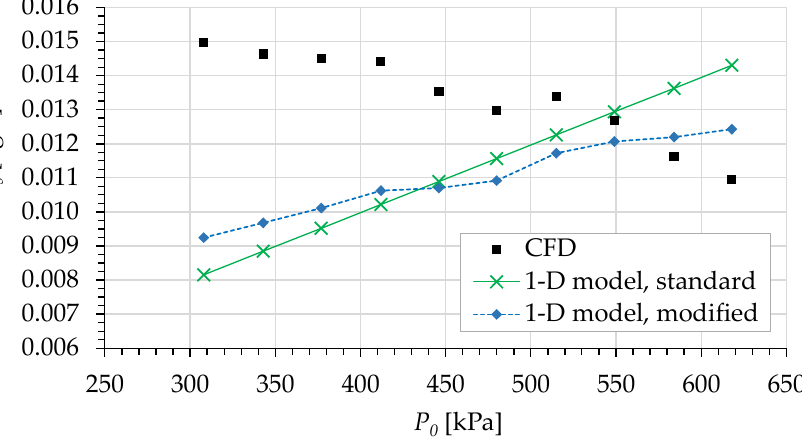
Figure 19. The secondary mass flow rates of ejector G2.2 obtained from various methods for different primary pressures. Table 5. The discrepancy (in percent) between the m s obtained from the one-dimensional analytical models (std and mod) and CFD for various ejectors.